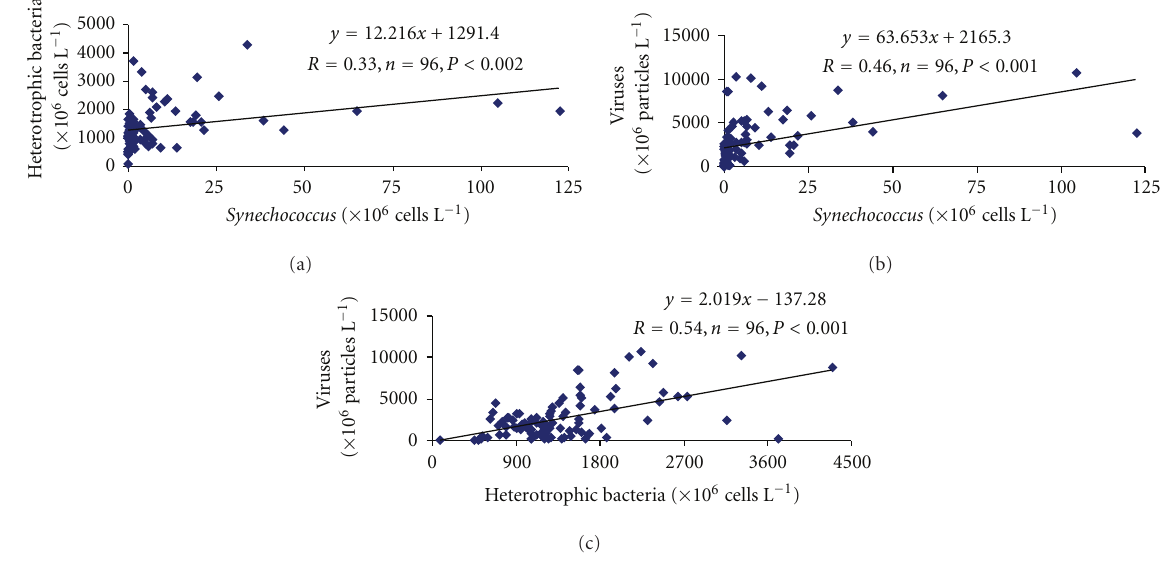
Figure 7: Linear relations between Synechococcus , heterotrophic bacteria, and viruses.